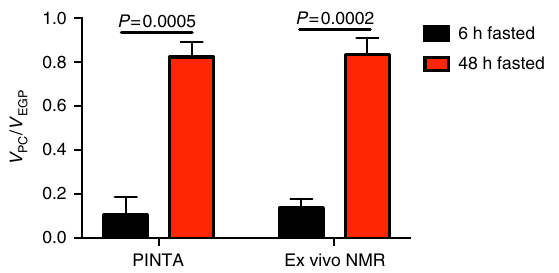
Fig. 4 V PC / V EGP increases with an extended fast. The V PC / V EGP ratios measured using the two techniques are identical in both 6 and 48 h fasted rats. Data are the mean ± S.E.M. of n = 4 rats per